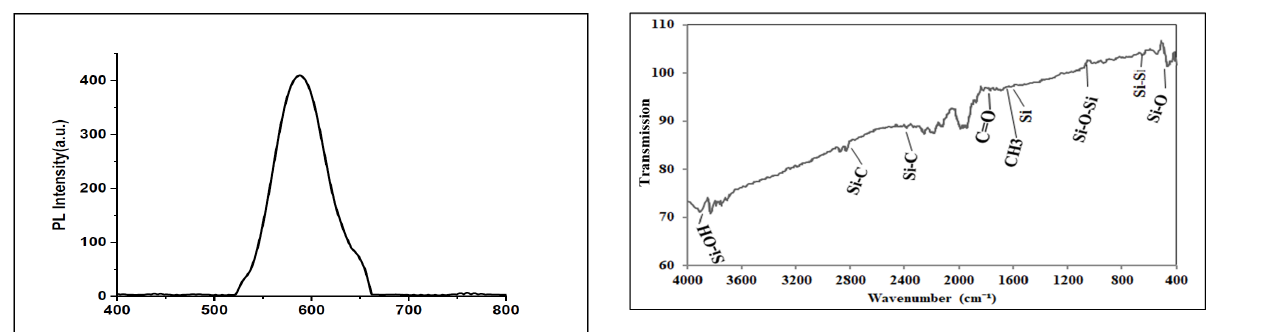
Figure 6: The Fourier Transform Infrared Spectroscopy (FTIR) of PS was produced with an etching current density of 12 mA / cm 2 , an etching period of 10 minutes, and HFC content of